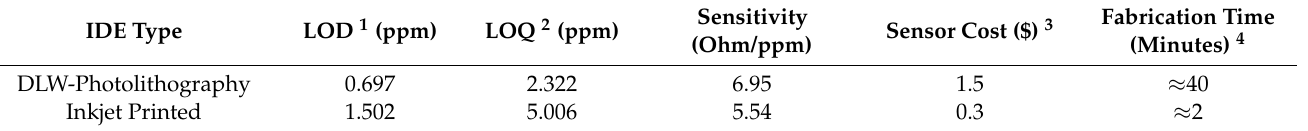
Table 1. Comparative data for nitrite sensing using the developed IDE